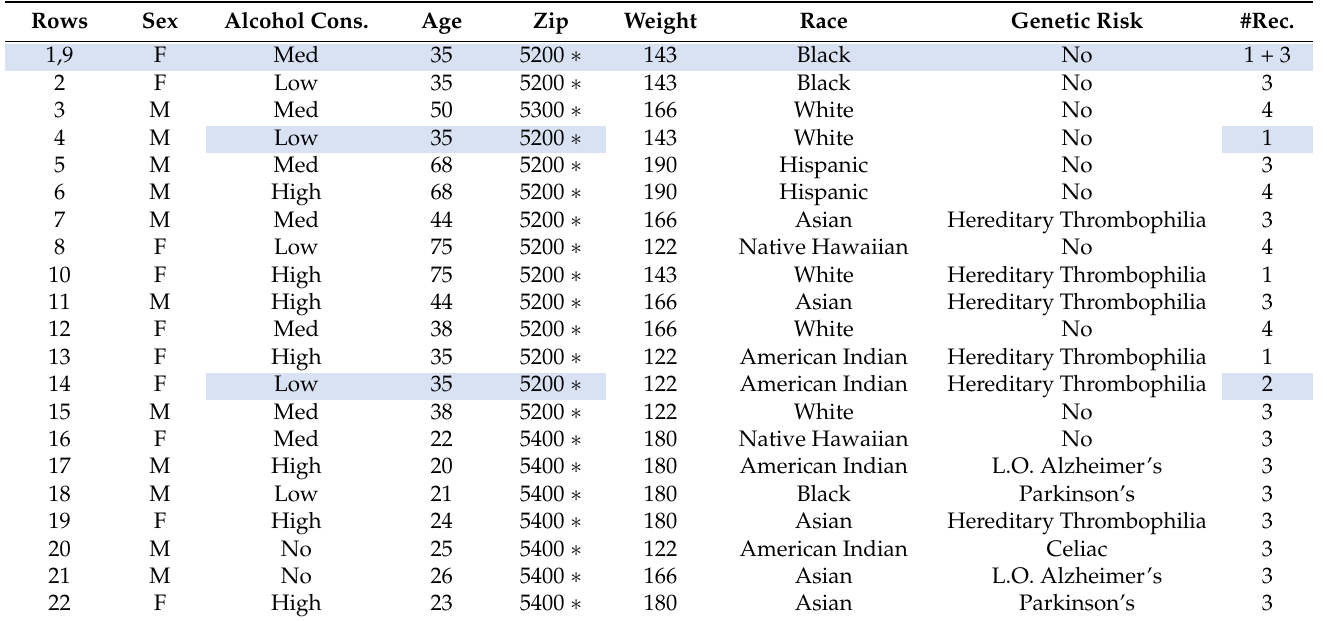
Table 4. A generalized Table after generalizing T on the Zip